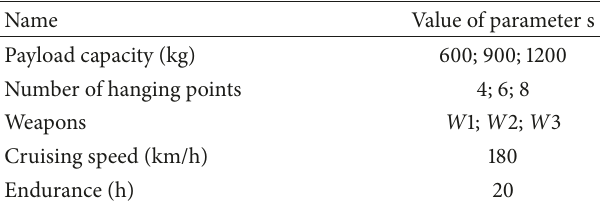
Table 3: UAV-related parameters.